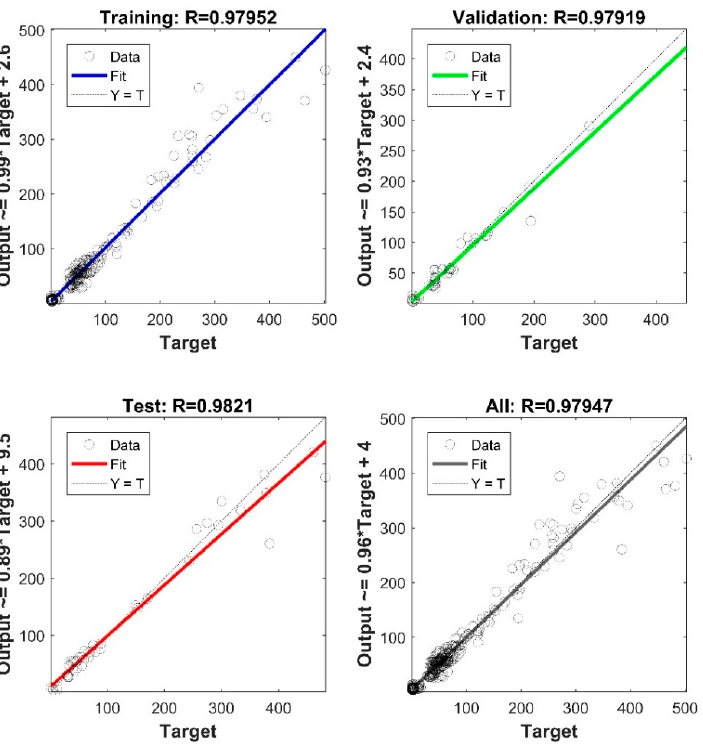
Figure 12. The performance of the developed 5-7-1 neural network to approximate the loss modulus in training, validation and testing.